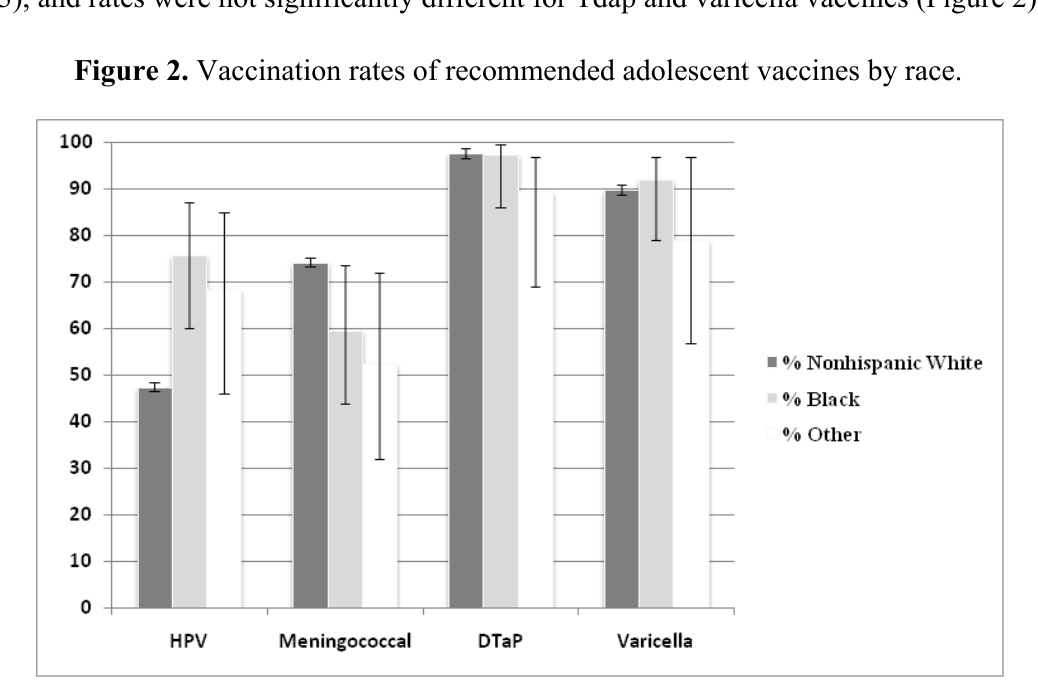
* Error bars represent 95% confidence interval.